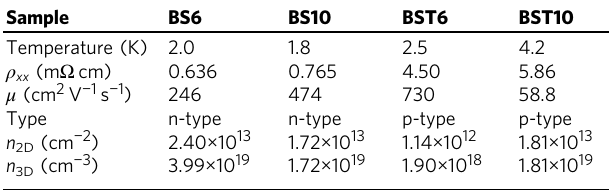
Bare TI samples made in the same batches with the BS{6, 10} and BST{6, 10} for USRMR study are referred in this table with the same names, but they are bare without CoFeB deposition. The resistivity, ρ xx , and sheet carrier concentration, n 2D , are measured from Hall bars of 1mm in length and 0.5mm width. Then the mobility, μ , and average carrier concertation, n 3D , are calculated